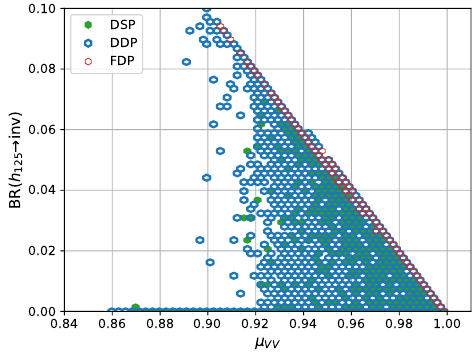
Figure 2 . Branching ratio of h 125 to DM particles vs. (cid:22) V V for the three DM